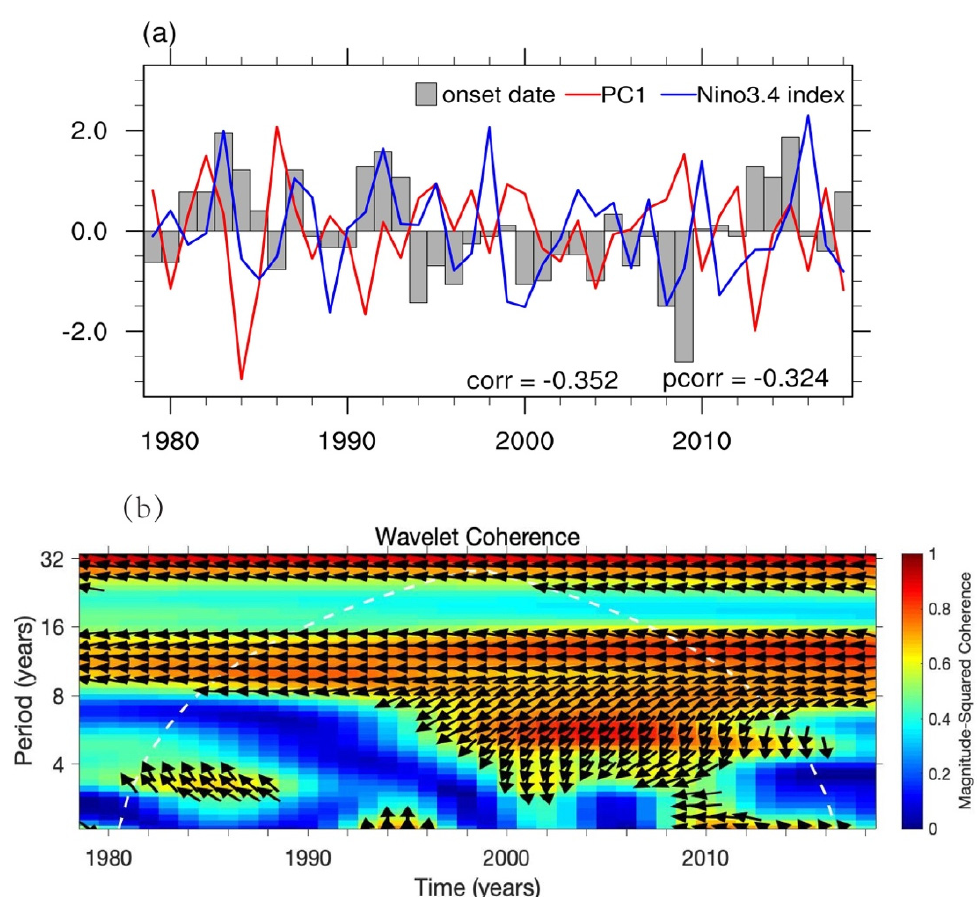
Figure 4. ( a ) The normalized time series of the SCSSM onset date (grey bar), PC1 of meridional wind anomalies at 500 hPa (red line), and the previous winter (December–February, DJF) Niño3.4 index (blue line) during 1979–2018. ( b ) The wavelet coherence and cross-spectrum between the normalized time series of PC1 and the SCSSM onset date.